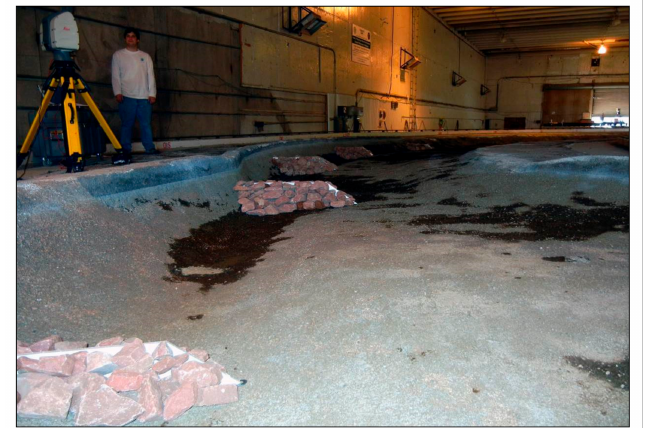
Figure 8. Bendway weir configuration looking downstream [23]. Plywood in the center of each structure is used for impermeability.